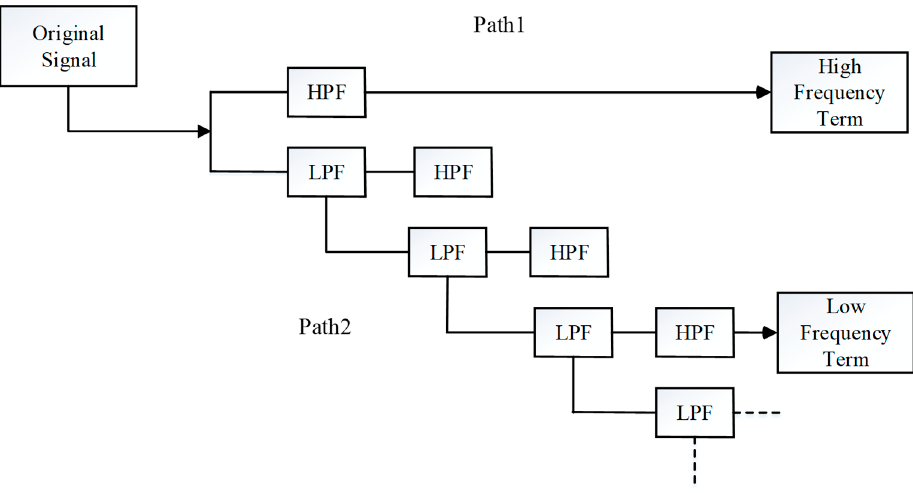
Figure 1. Multi-resolution analysis using wavelet transform [30].